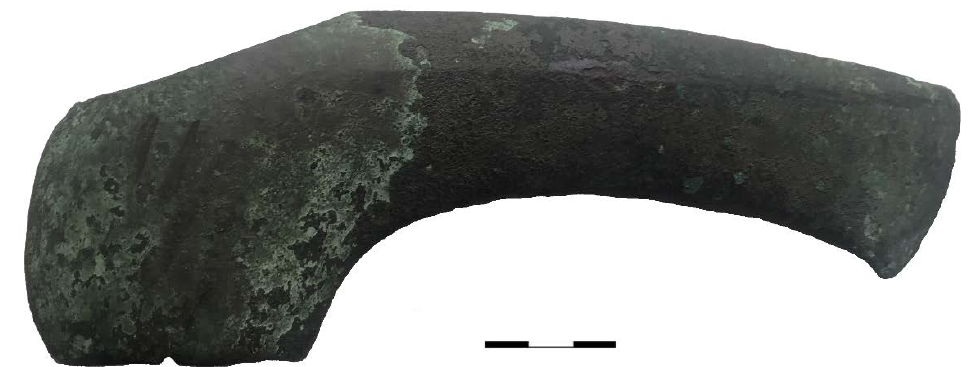
Figure 1. A photo of the bronze axe from the Malo-Kizilsky settlement of the Abashevo culture. A scale line of 30 mm is presented.